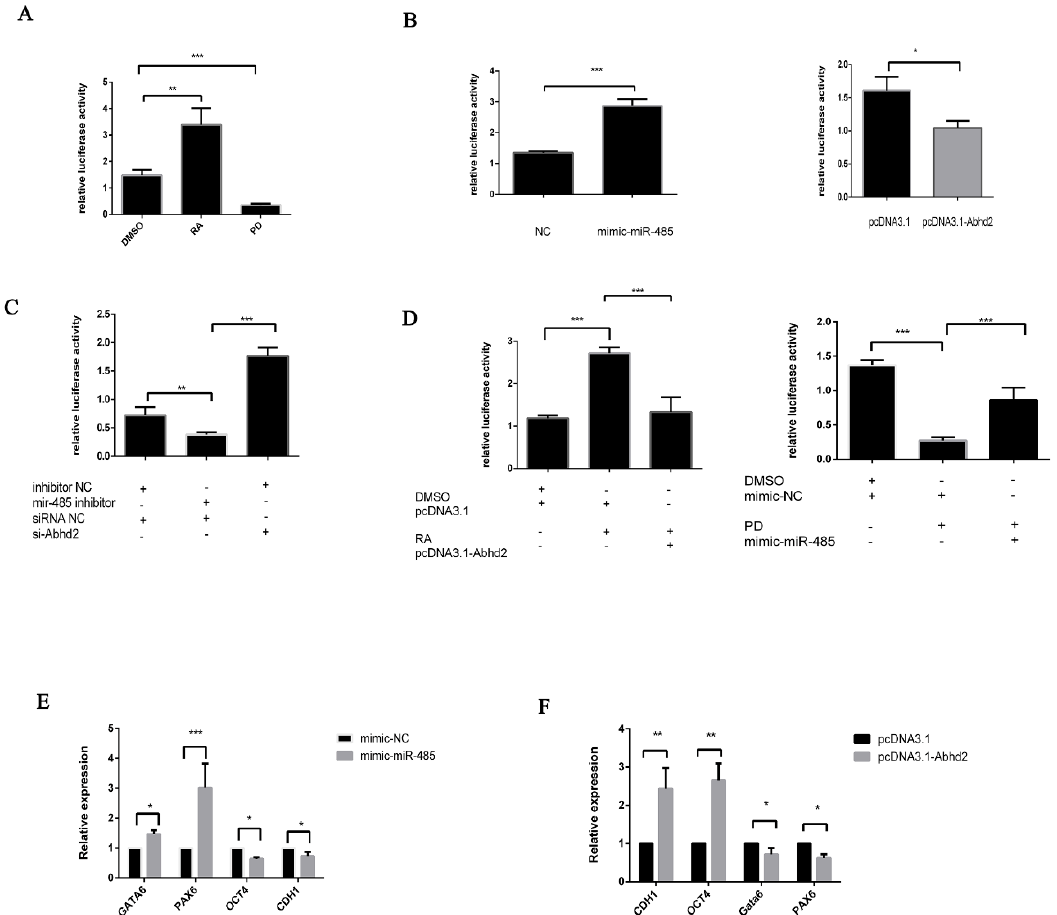
Figure 3. miR-485 and Abhd2 are involved in the MAPK/Erk pathway during RA-induced differentiation. ( A ) dual-luciferase reporter assay of MAPK/ERK pathway influenced by RA and PD. Pathway reporter luciferase vector pSRE-TA-luc (including negative control) and internal control pRL-SV40 were co-transfected into F9 ECs for 36 h. after transfection 6 h, 2 μ M RA, PD or DMSO was added into medium. Luciferase activity is presented relative to negative control pTA-luc. Data are presented as the mean ± SD of three independent experiments (* p < 0.05; ** p < 0.01; *** p < 0.001). ( B) Left panel: dual-luciferase reporter assay of MAPK/ERK pathway influenced by miR-485. Right panel: dual-luciferase reporter assay of MAPK/ERK pathway influenced by Abhd2. Pathway reporter luciferase vector pSRE-TA-luc pRL-SV40 were co-transfected with NC, mimic-485, pcDNA3.1, pCDNA3.1-Abhd2. ( C ) dual-luciferase reporter assay of MAPK/ERK pathway influenced by suppressing miR-485 and Abhd2. pRL-SV40 were co-transfected with inhibitor mir-485, si-NC or si-Abhd2 into F9 ECs for 36 h. Luciferase activity is presented relative to negative control pTA-luc. ( D ) Left panel: dual-luciferase reporter assay of MAPK/ERK pathway influenced by RA and Abhd2. Pathway reporter luciferase vector pSRE-TA-luc and internal control pRL-SV40 were co-transfected with pCDNA3.1, pCDNA3.1-Abhd2 into F9 ECs for 36 h. after transfection 6 h, 2 μ M RA or DMSO was added into medium. Luciferase activity is presented relative to negative control pTA-luc. Right panel: dual-luciferase reporter assay of MAPK/ERK pathway influenced by PD and miR-485. Pathway reporter luciferase vector pSRE-TA-luc and internal control pRL-SV40 were co-transfected with mimic-NC or mimic-miR-485 into F9 ECs for 36 h. after transfection 6 h, 2 μ M PD or DMSO was added into medium. Luciferase activity is presented relative to negative control pTA-luc. ( E ) qPCR analysis of downstream genes in MAPK/ERK pathway in F9 EC cells transfected with NC or mimic of miR-485 for 36 h. Gapdh was used to normalize template levels. ( F ) qPCR analysis of downstream genes in MAPK/ERK pathway in F9 EC cells transfected with pcDNA-3.1 or pcDNA-3.1-Abhd2 for 36 h. Gapdh was used to normalize template levels.